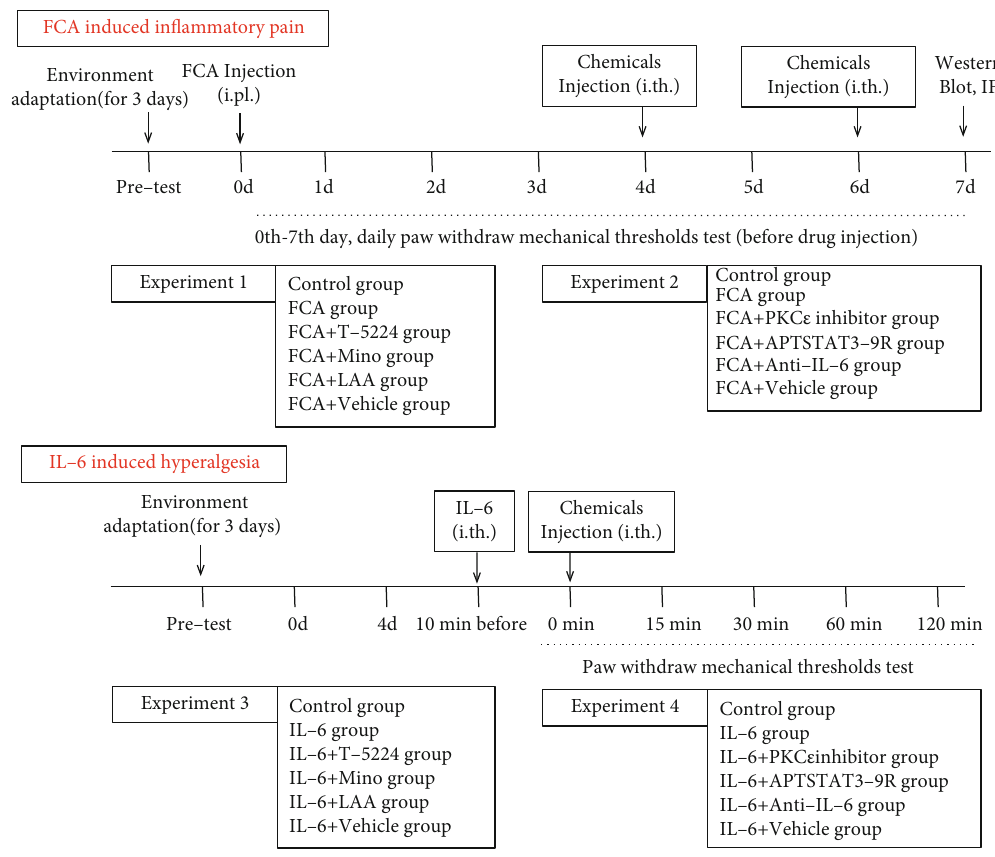
Figure 1: Schema of the experimental protocol. FCA: Freund complete adjuvant; IF: immuno fl uorescence; IL-6: interleukin-6; i.pl.: intraplantar; i.th.: intrathecal; LAA: L-2-aminoadipic acid; Mino: minocycline; PKC ε : protein kinase C